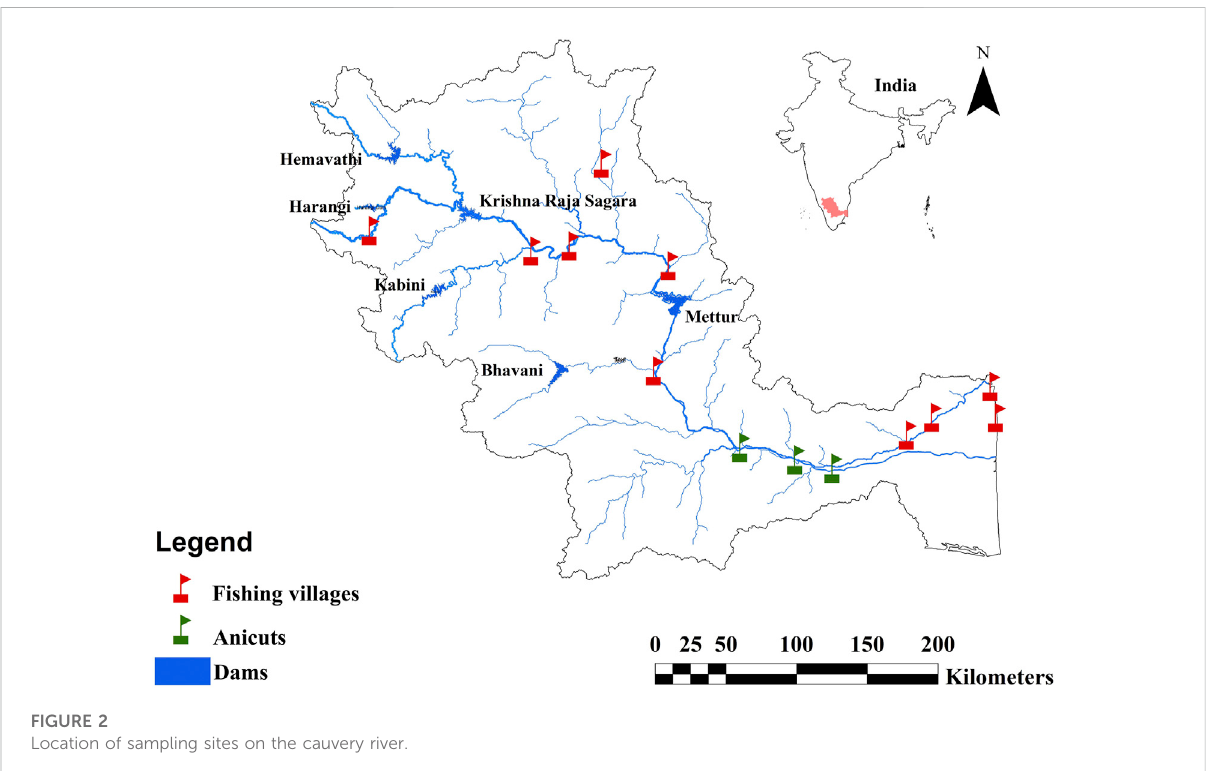
FIGURE 2 Location of sampling sites on the cauvery river.